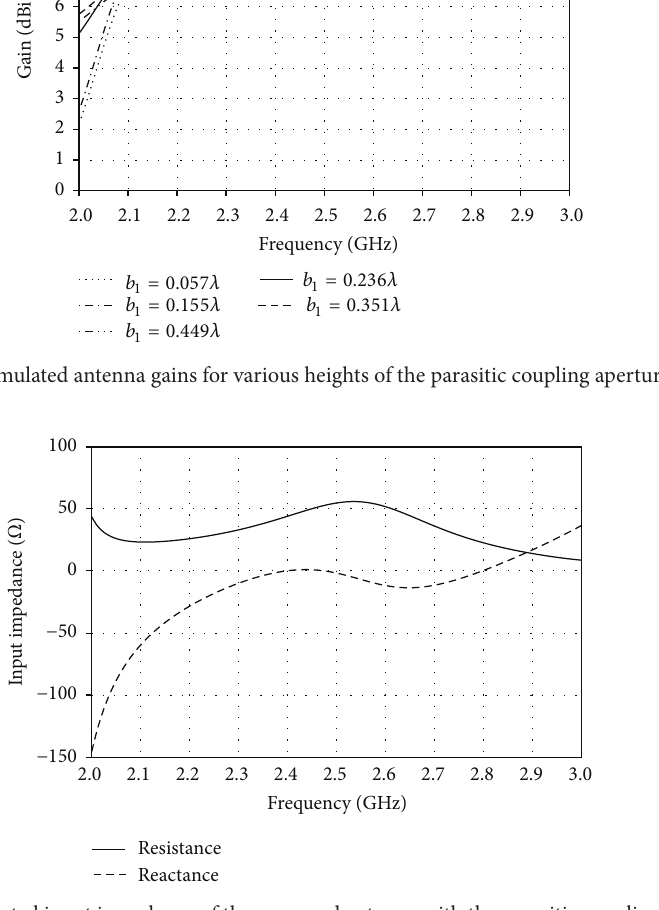
Figure 20: Simulated input impedance of the proposed antenna with the parasitic coupling apertures.